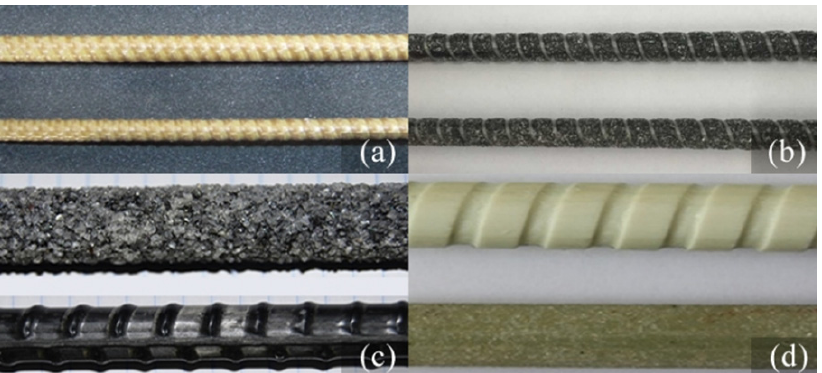
Figure 3. FRP bars and fiber types ( a ) Aramid [39]; ( b ) Basalt [40]; ( c ) Carbon [41]; ( d ) Glass [42].